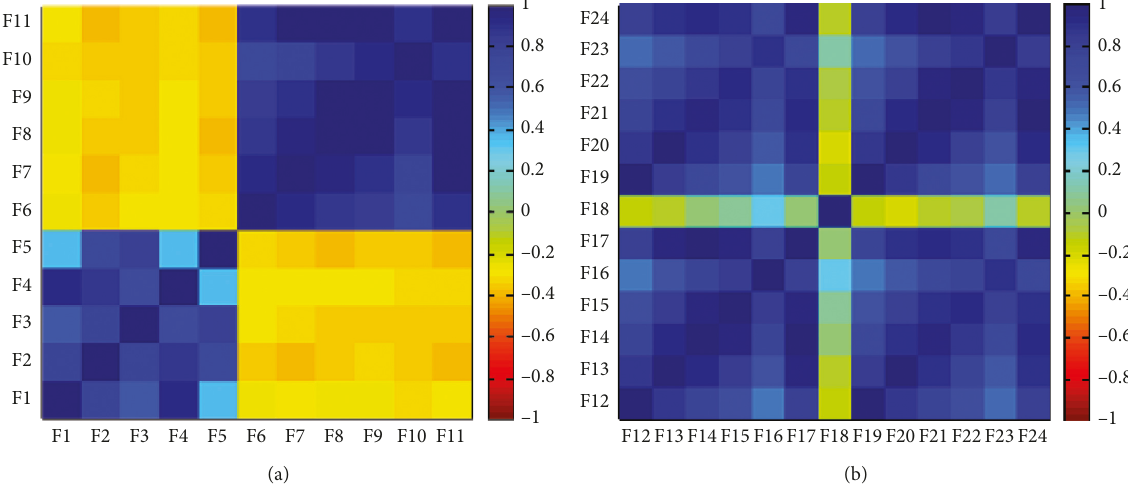
Figure 4: Analysis of correlations between selected features: (a) behavioral features; (b) physiological features.